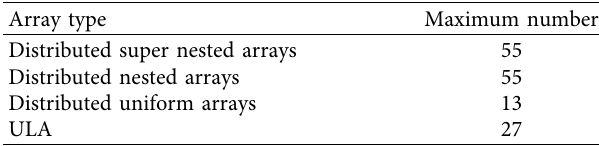
Figure 16: The simulation results of RMSE changing with the number of source signals. Table 1: Maximum number of detectable source